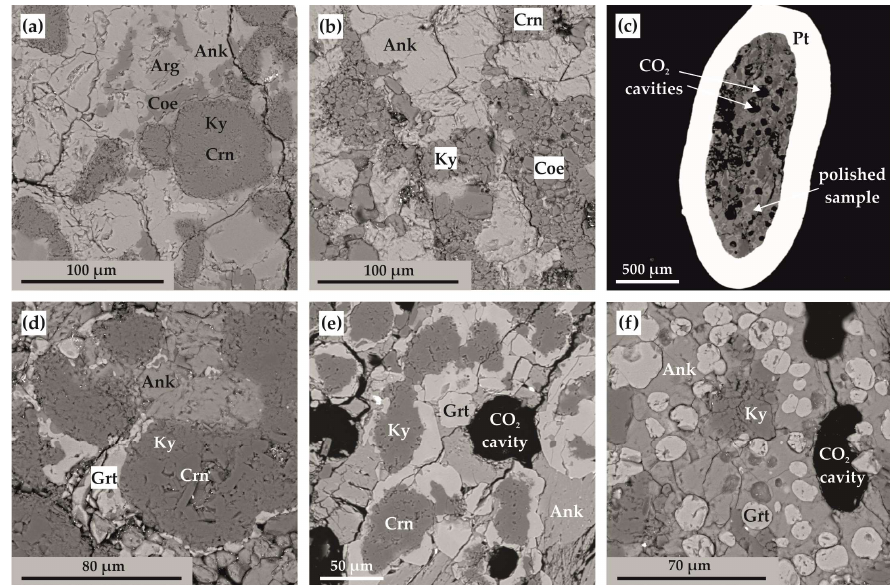
Figure 7. SEM micrographs (BSE regime) of polished sample fragments after experiments in Ca(Mg,Fe)(CO 3 ) 2 -SiO 2 -Al 2 O 3 system: ( a ) polycrystalline aggregate of ankerite, aragonite, coesite, kyanite, and corundum (N 1744-A); ( b ) polycrystalline aggregate of ankerite, coesite, kyanite, and corundum (N 2135-A); ( c ) section of Pt capsule with a sample and fluid cavities therein (N 2113-A); ( d ) zoned aggregates of corundum, kyanite, and garnet in ankerite polycrystalline matrix (run N 1738-A); ( e ) zoned aggregates of corundum, kyanite, and garnet as well as CO 2 fluid cavities in ankerite polycrystalline matrix (N 2113-A); ( f ) isometric garnet crystals and CO 2 fluid cavities in ankerite-kyanite polycrystalline aggregate (N 2145-A); Ank—ankerite, Arg—aragonite, Coe—coesite, Ky—kyanite, Crn—corundum, Grt—garnet.